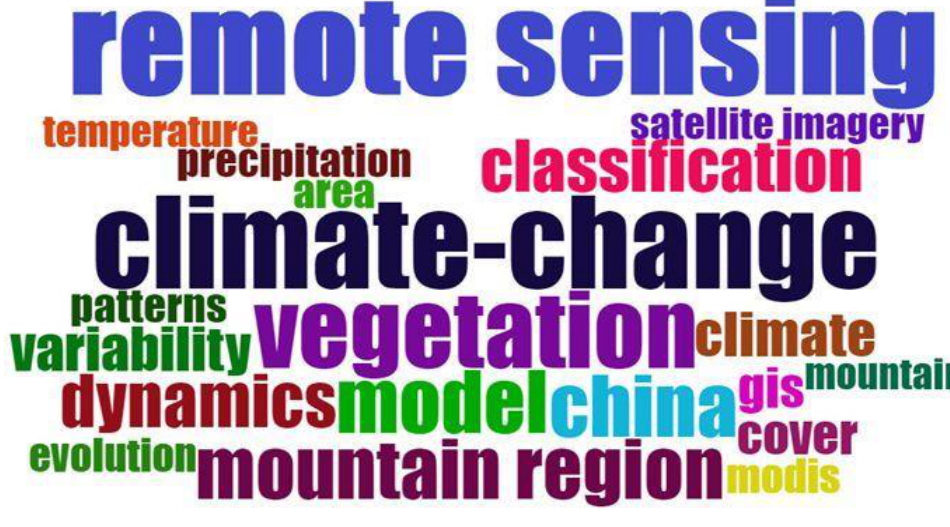
Figure 4. Word cloud showing the top 20 keywords commonly used in studies focused on the application of remote sensing methods in mountainous environments.